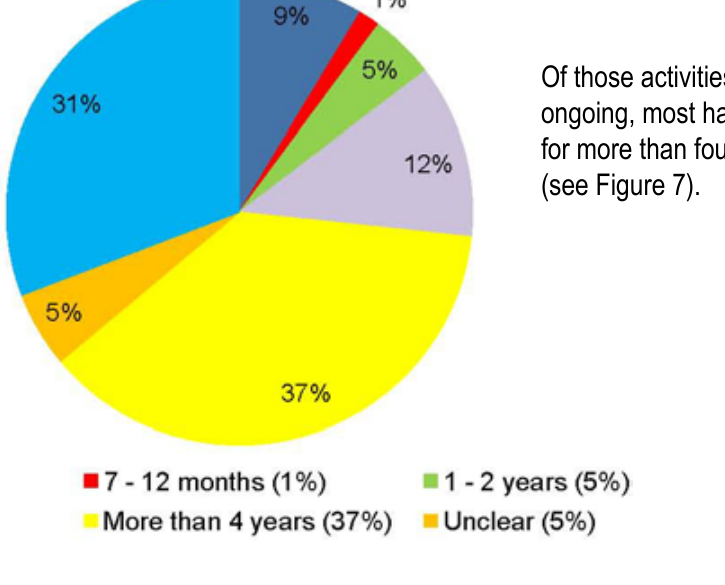
Figure 7: Length of time in existence (shown as